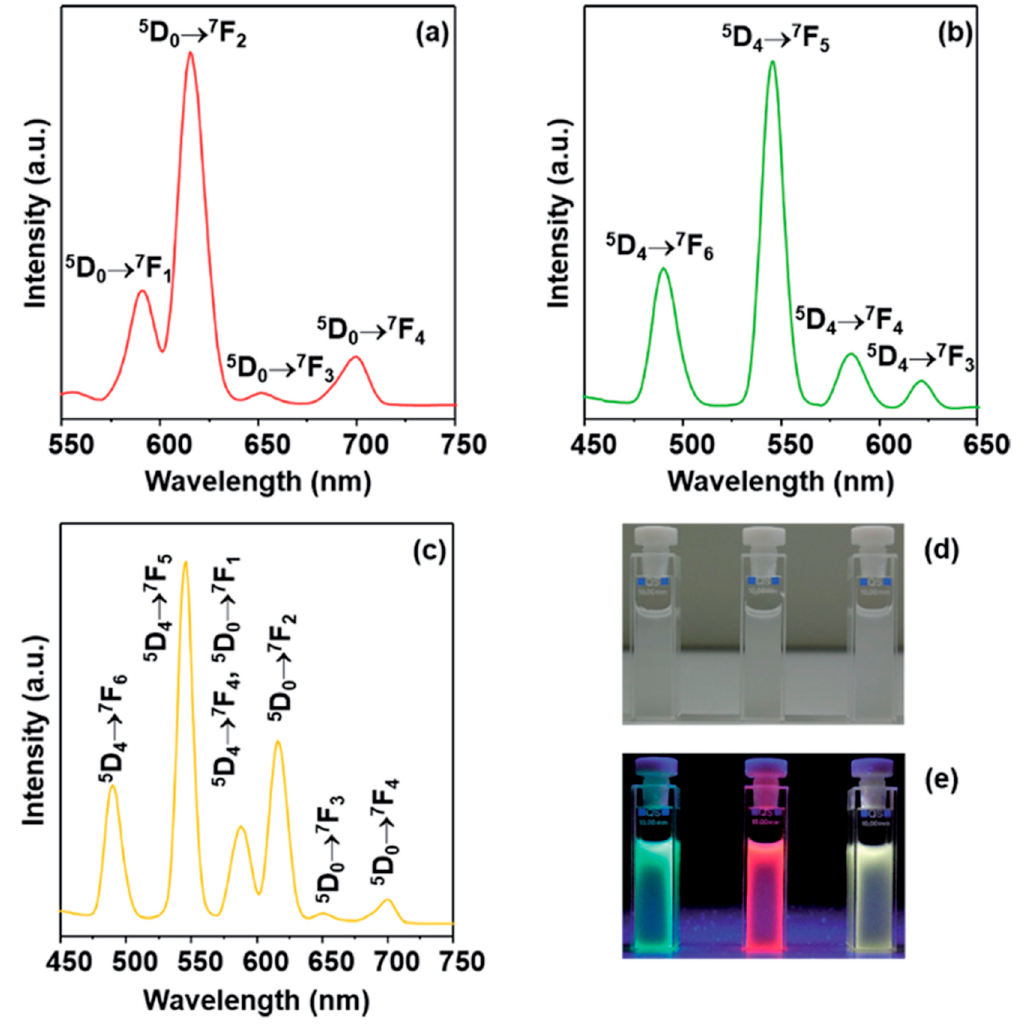
Figure 7. Emission spectra of ( a ) Eu-grafted DPA-‘PMO’, ( b ) Tb-grafted DPA-‘PMO’ and ( c ) Eu/Tb- grafted DPA-‘PMO’. Images of the three samples under sunlight ( d ) and under a UV lamp ( e )